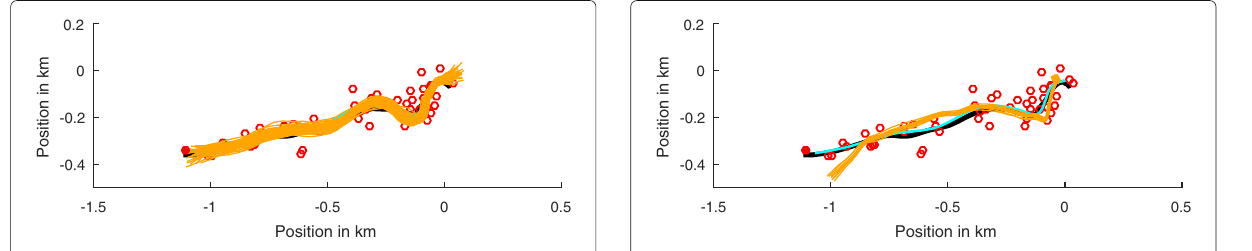
Fig. 11 An ensemble with N = 10 after updating with all measurements in the order y 1 , ... y L . The smaller ensemble is more condensed and does not cover the RTS solution well